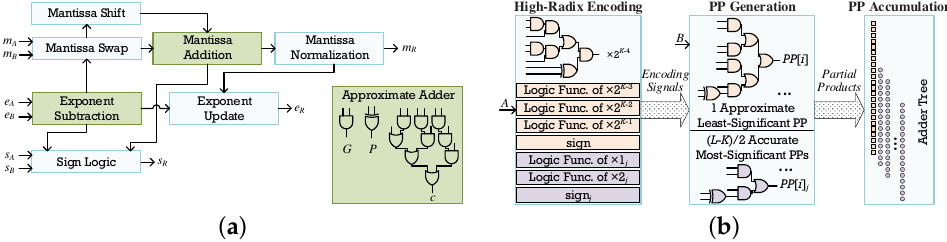
Figure 5. The approximate arithmetic circuits used in our M -QAM demodulation